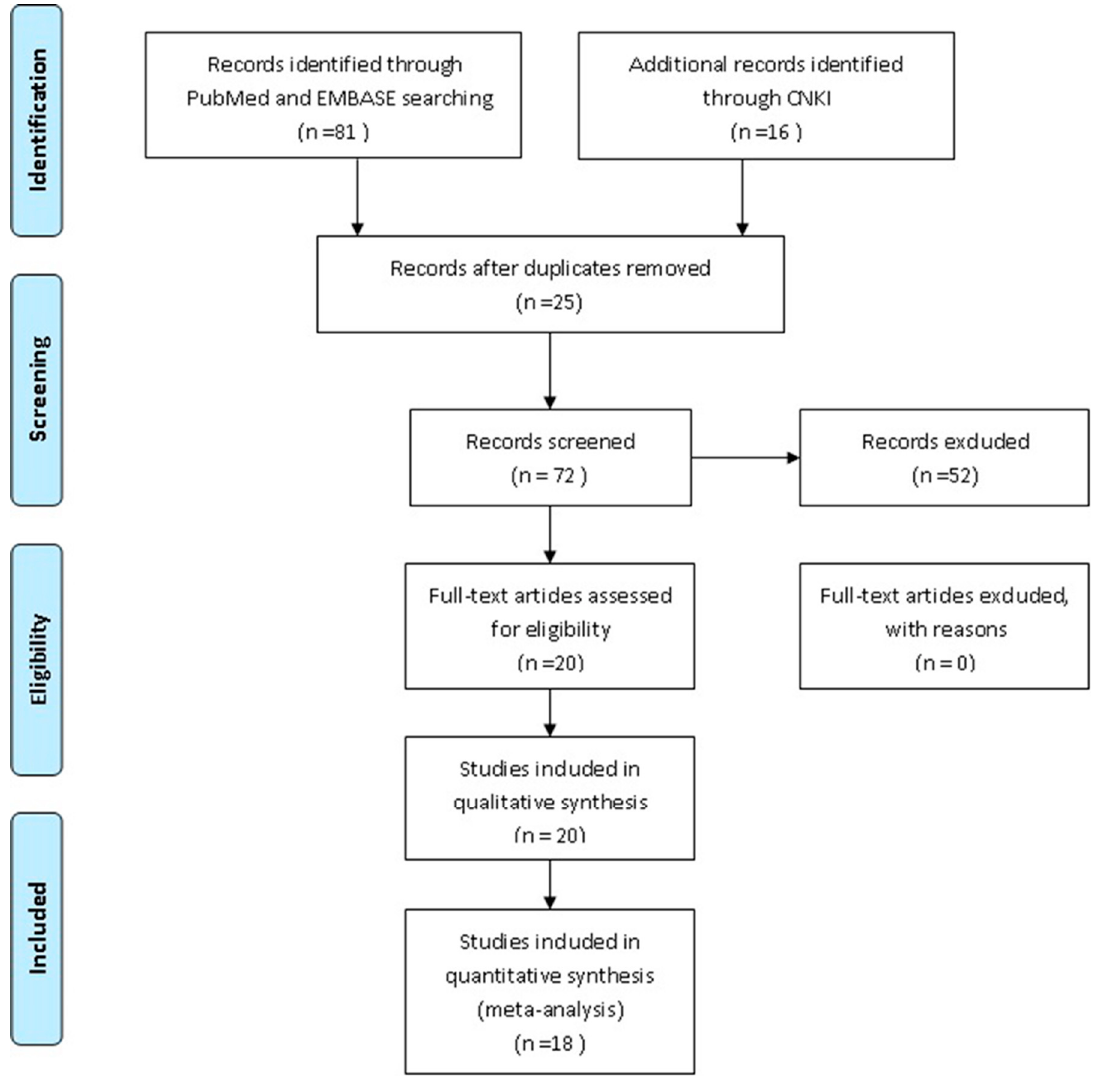
Figure 1. Flow chart of the literature search.